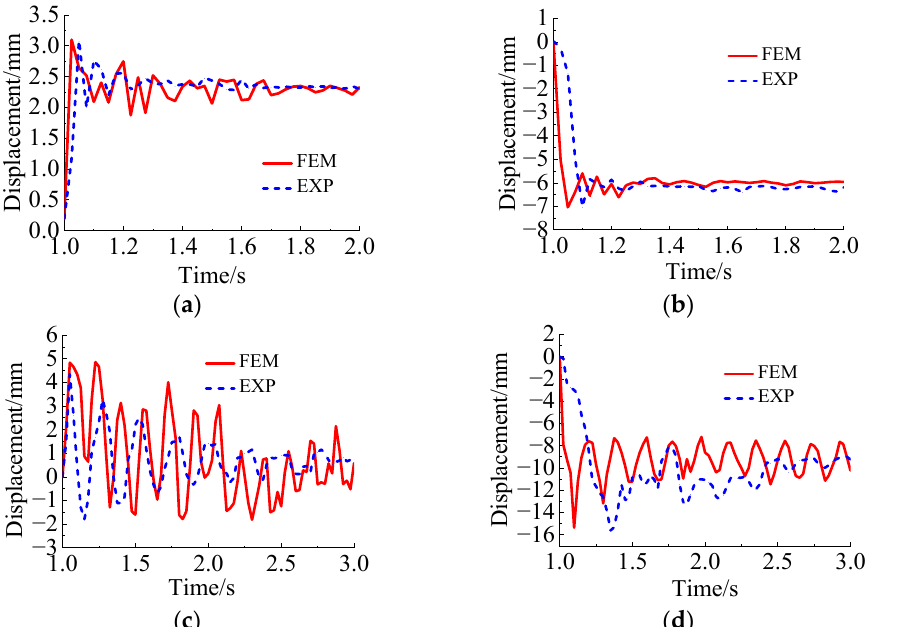
Figure 12. The time history plots of displacement due to the long and short suspenders fracturing: ( a ) displacement of the arch rib when the 1# suspender breaks; ( b ) displacement of the bridge deck when the 1# suspender breaks; ( c ) displacement of the arch rib when the 6# suspender breaks; ( d ) displacement of the bridge deck when the 6# suspender breaks.